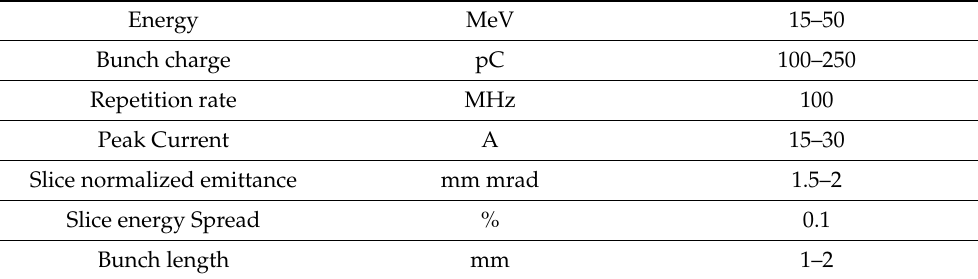
Table 1. Electron beam